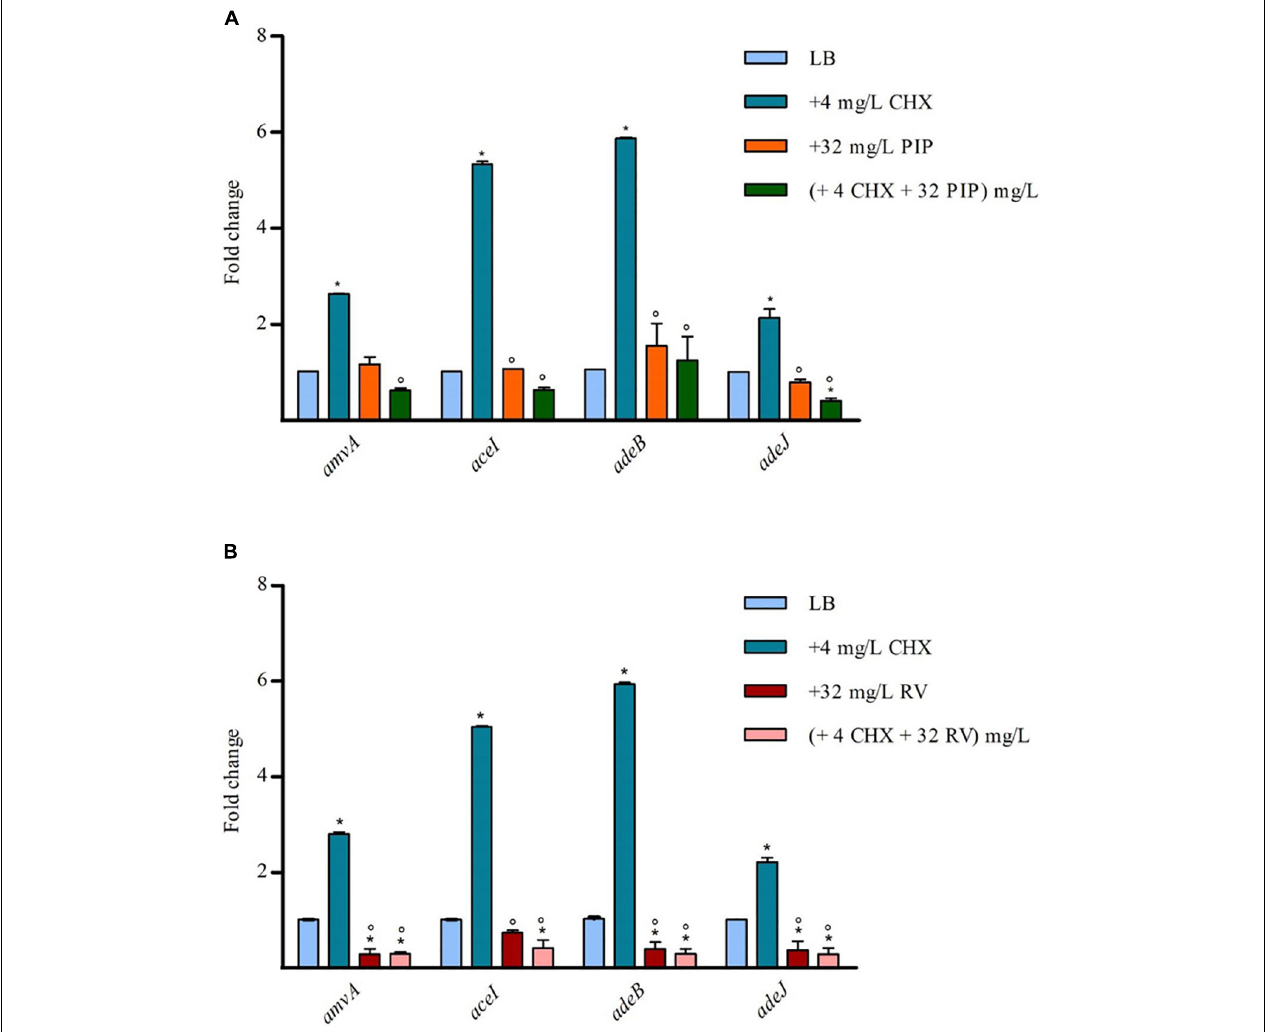
FIGURE 5 | RT-qPCR assay of amvA , aceI , adeB, and adeJ genes expression in the absence (LB) or presence of 4 mg/L CHX alone or in combination with 32 mg/L PIP (A) or 32 mg/L RV (B) . Relative number of transcripts of each gene was normalized in each condition and calculated using the 2 - (cid:49)(cid:49) ct method compared to the expression level in LB control. The mean ± standard deviation of relative number of transcripts is shown for each gene. All experiments were performed in triplicate. P -values were calculated using ANOVA (* p < 0.01 vs. LB; ◦ p < 0.01 vs. 4 mg/L CHX).